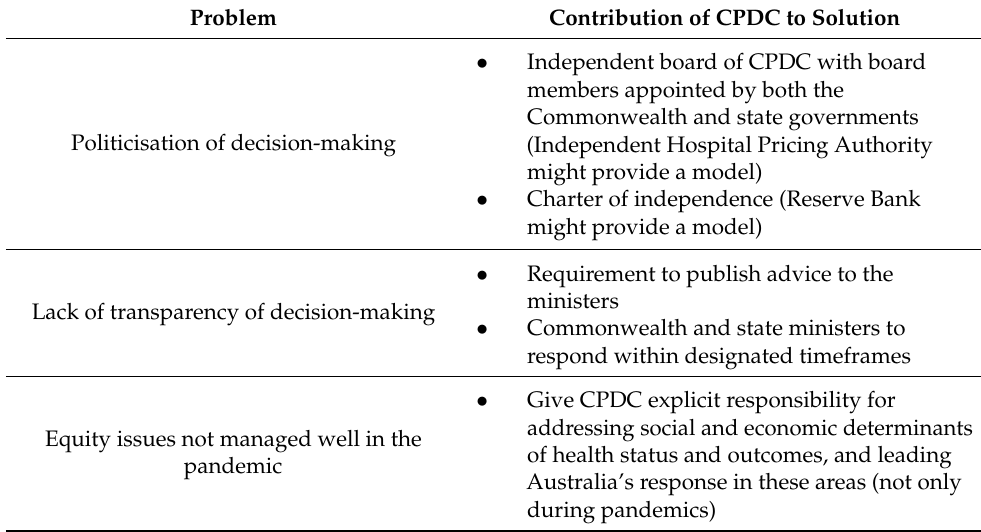
Table 2. The role of a Centre for Prevention and Disease Control in addressing problems seen in national management of the SARS-CoV-2